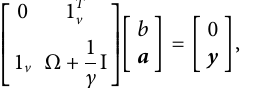
FIGURE 1 Schematic diagram for the i th sliding surface of a discrete